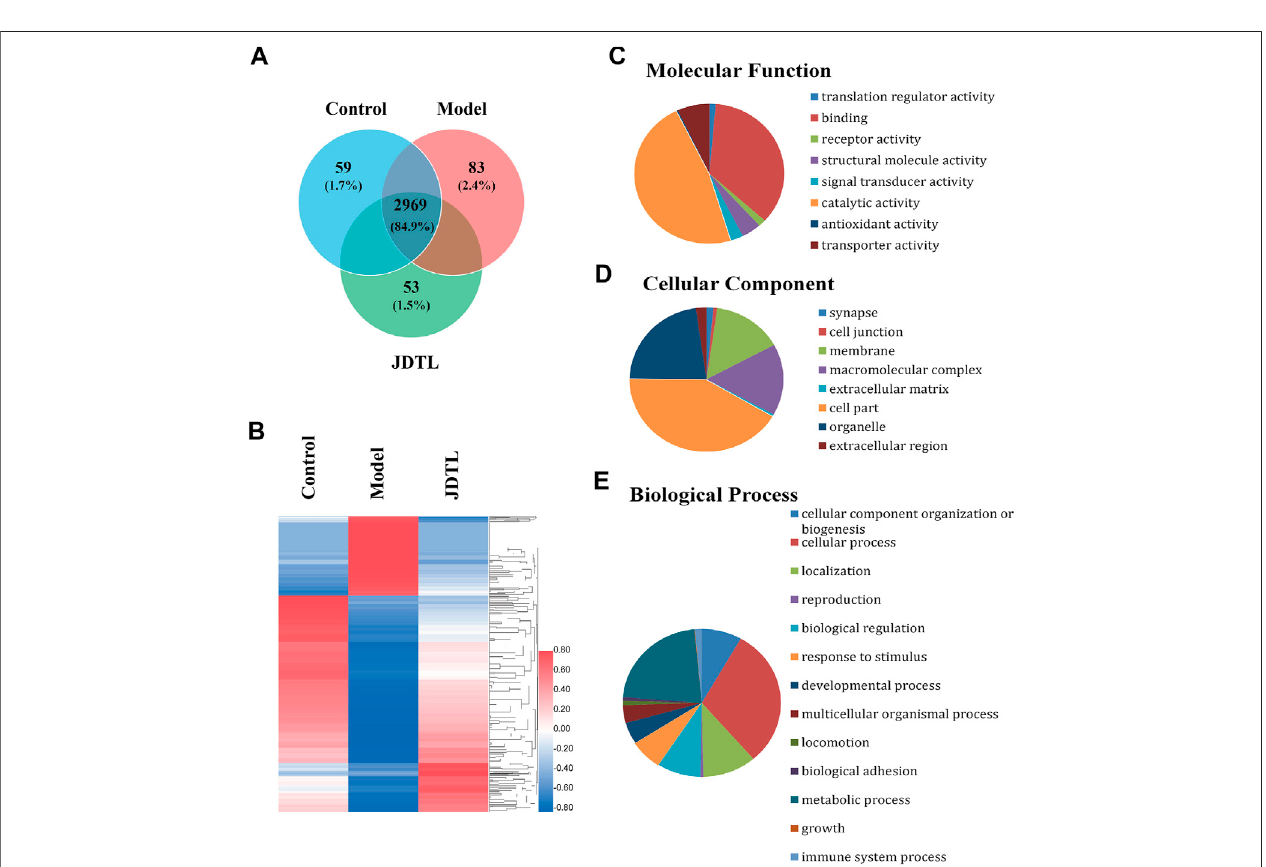
FIGURE 5 | Summary statistics of LC-MS/MS analysis. (A) Area-proportional Venn diagram depicts the overlap of the identi fi ed proteins of Control, Model, and JDTLG groups. (B) Heat map analysis of the DAPs among the three groups. (C – E) Molecular functional assignments, cellular component and biological process of the DAPs according to gene ontology